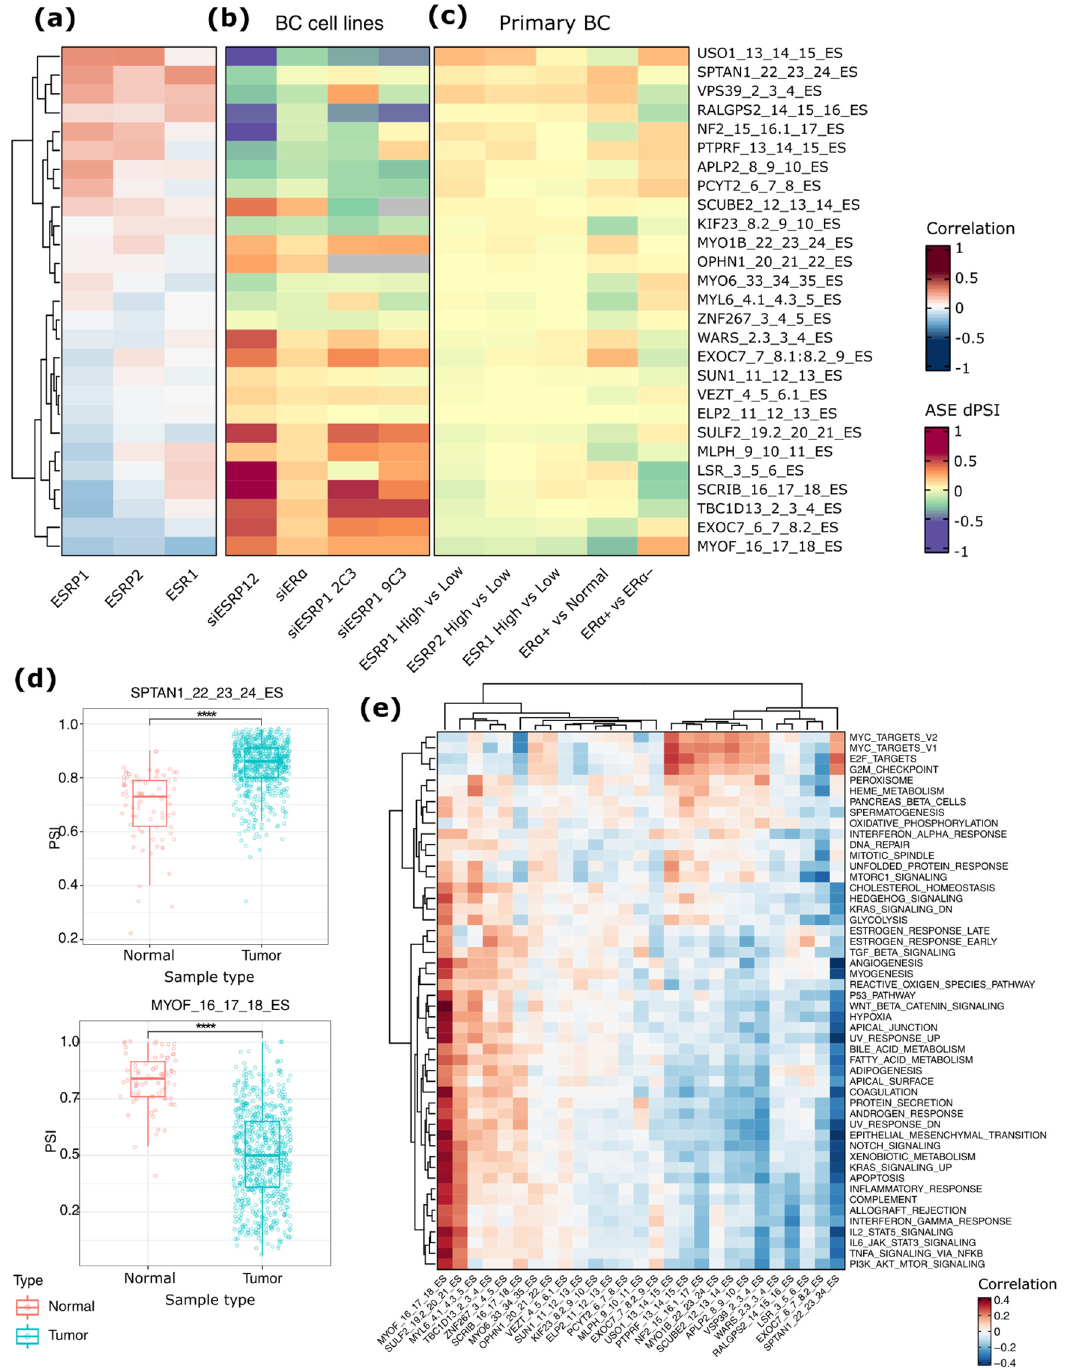
Figure 5. Analysis of the 27 ASEs overlapping between the two experiments in tumor data. ( a ) heat map plot showing the correlation between ESRP1, ESRP2, and ESR1 genes expression and the expression of ASEs exons in tumor samples, whose inclusion changes (dPSI values) upon ESR1 or ESRP1/2 silencing in wild type (MCF-7) or resistant (LCC2, LCC9) BC cell lines are reported in ( b ). ( c ) Heat map plot showing the inclusion levels of the 27 ASEs in primary BC samples classified according to the expression levels of ESRP1, ESRP2, and ESR1 genes. ( d ) Box plots representing the inclusion levels (percent spliced-in index—PSI) of exon 22 of SPATIN1 and exon 16 of MYOF genes in tumor versus normal samples (****, p < 0.0001). ( e ) Heat map showing the correlation scores between ASEs and the enriched molecular pathways obtained using PEGASAS [29].